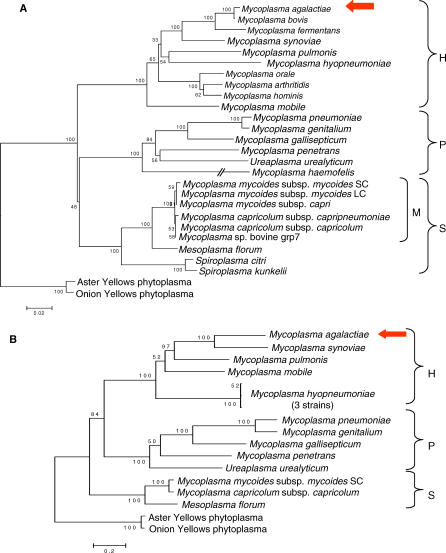
Phylogenetic Tree of Selected Mollicutes of the Spiroplasma/Mycoplasma Branch Inferred from 16S rDNA Sequences [3] or from Concatenated Shared Proteins(A) The tree was constructed using the distance (neighbor joining) method and the gaps complete deletion option of the MEGA2 software. A bootstrap of 500 replicates was performed; the number on each node indicates the percentage with which each branch topology was supported. The phylogenetic groups spiroplasma, pneumoniae, and hominis are indicated by S, P, and H, respectively. M, mycoides cluster. Candidatus phytoplasma asteris (Onion Yellows strain) and Aster Yellows phytoplasma were chosen as outgroup species.(B) 30 COGs shared by all sequenced mollicute genomes were extracted from the MolliGen database (see Materials and Methods). After alignment of each COG, the aligned sequences were concatenated. The tree was constructed using the maximum likelihood method (PhyML). A bootstrap of 100 replicates was performed; the number on each node indicates the percentage with which each branch topology was supported. The phylogenetic groups spiroplasma, pneumoniae, and hominis are indicated by S, P and H, respectively. Candidatus phytoplasma asteris (Onion Yellows strain) and Aster Yellows phytoplasma were chosen as outgroup species.